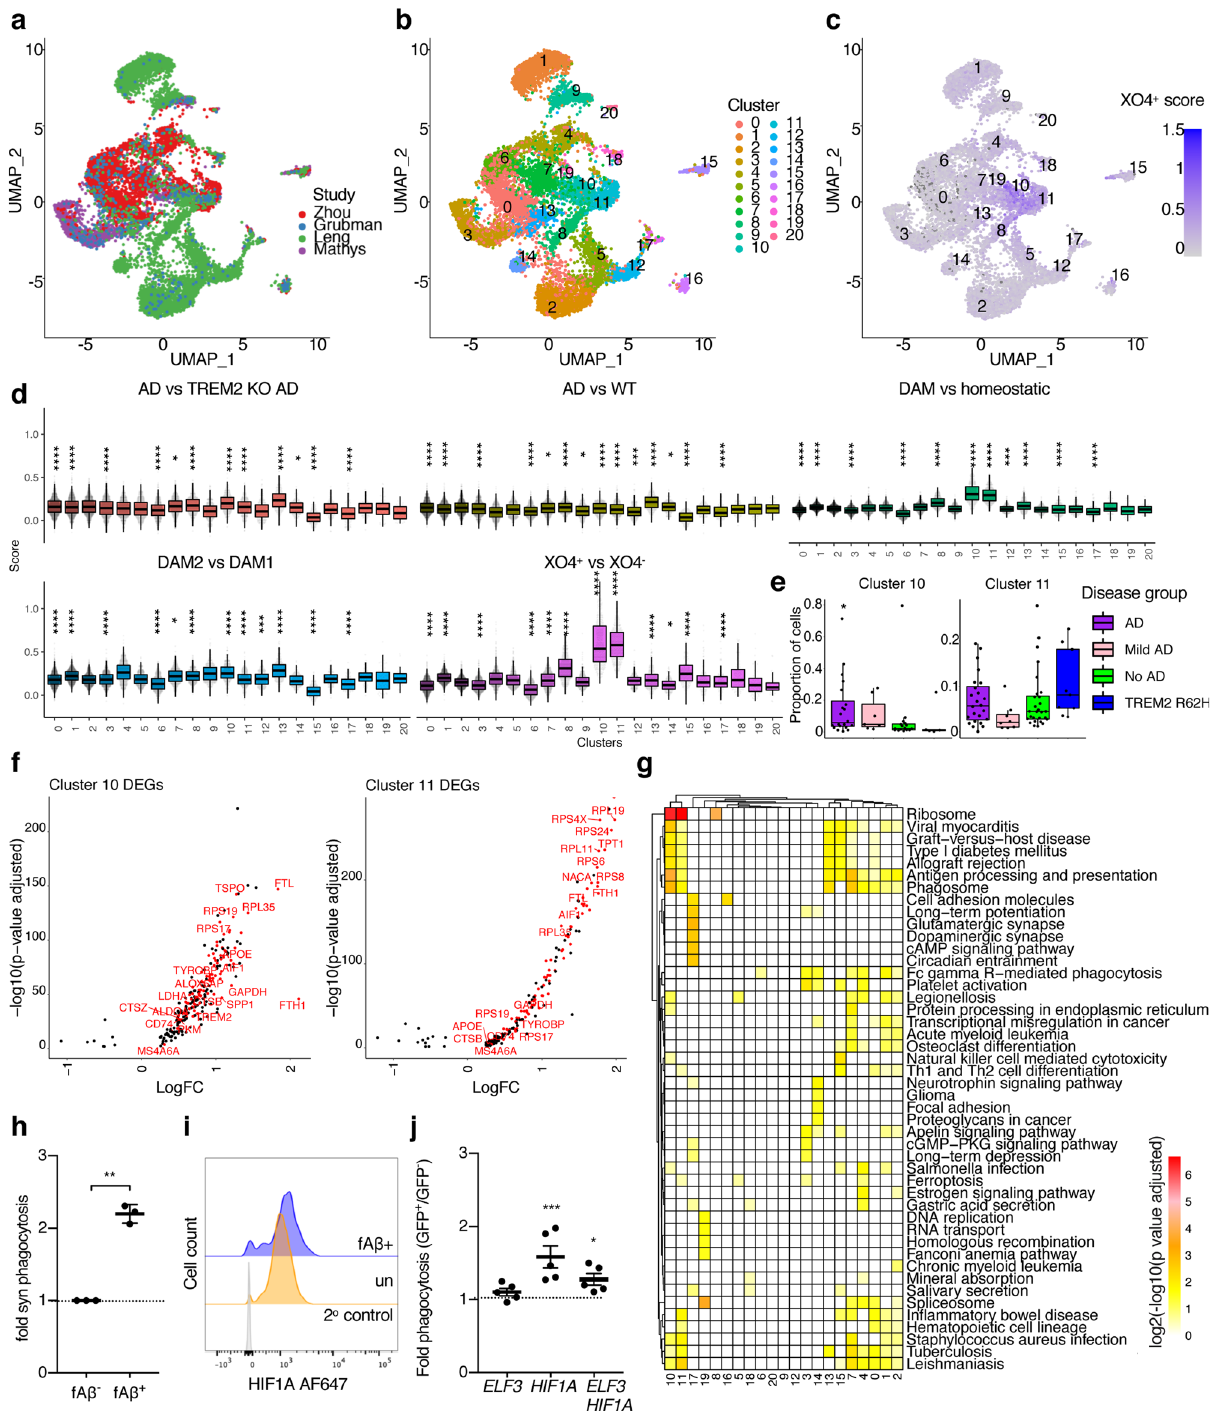
IPA, treatment of cells in vitro with the mTOR inhibitor, rapa- mycin, blocked MyD88/BMP9-dependent induction of microglial genes within the Hif1a regulon associated with the XO4 + sig- nature (Fig. 6e). Moreover, rapamycin treatment reduced TREM2 expression at both the RNA and protein levels and induced the homeostatic marker CX3CR1 (Supplementary Fig. 13a, b). The network of genes induced by Pam3csk and repressed by rapa- mycin in vitro signi fi cantly overlapped with the upregulated genes associated with XO4 + microglia (65 genes overlap, p = 3.17 × 10 − 20 , hypergeometric test; Supplementary Fig. 13c)